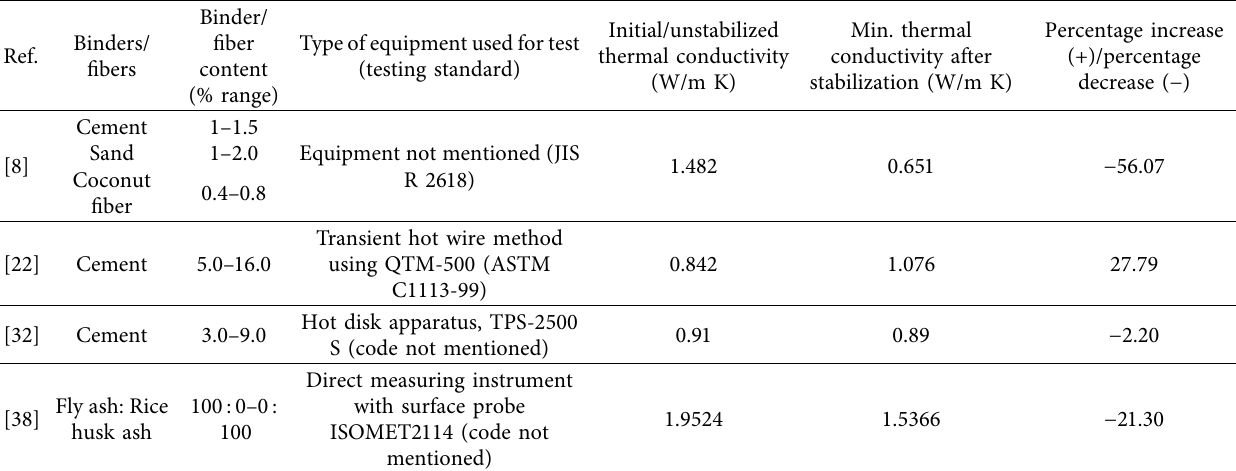
Table 11: Compressive strength of unfired admixed soil blocks as reported in the reviewed articles.